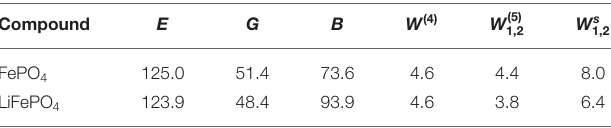
TABLE 5 | The computed by Maxisch and Ceder (2006) with the DFT+ U method Young’s ( E ), shear ( G ) and bulk moduli ( B ) for FePO 4 and LiFePO 4 compounds. The values are given in